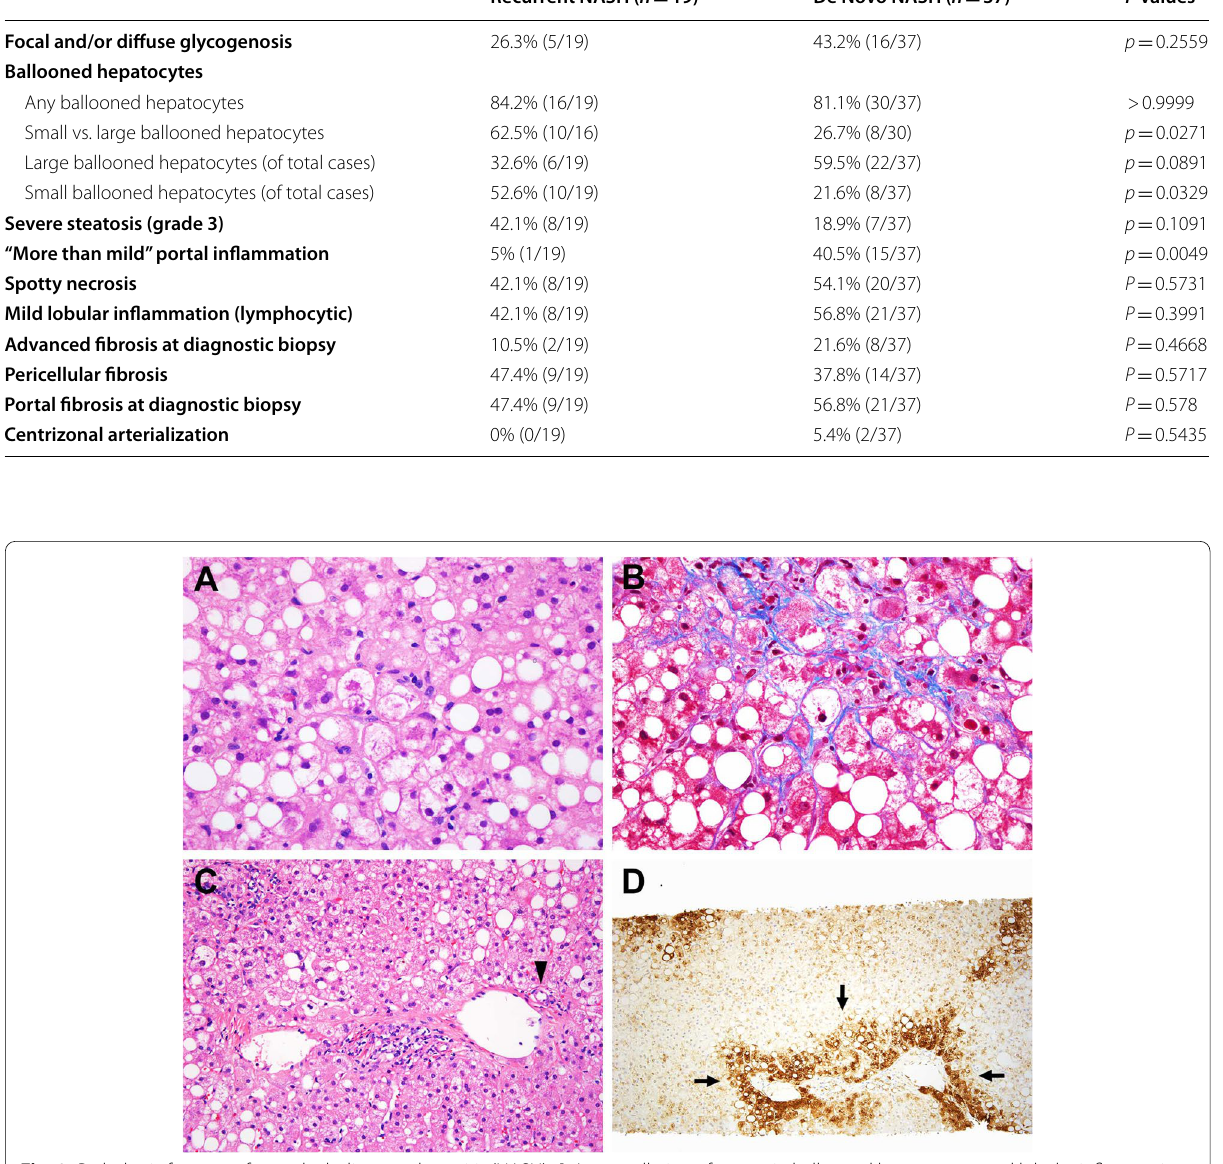
Fig. 2 Pathologic features of non‑alcoholic steatohepatitis (NASH). A A constellation of steatosis, ballooned hepatocytes, and lobular inflammation. B Centrizonal sinusoidal fibrosis is present around the ballooned hepatocytes. C Examples of a centrizonal artery (arrowhead) in a central zone. Glutamine synthetase immunostain is available in this case and highlights pericentral hepatocytes